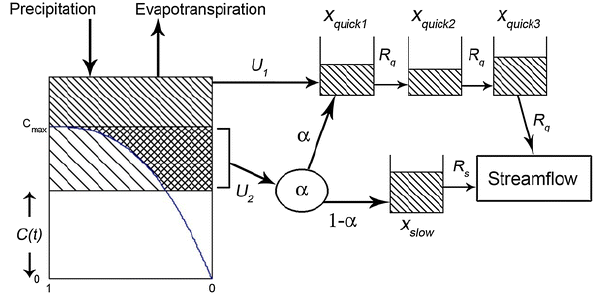
Figure A1. Schematic diagram of the Hymod model (adapted from Van Delft et al.,